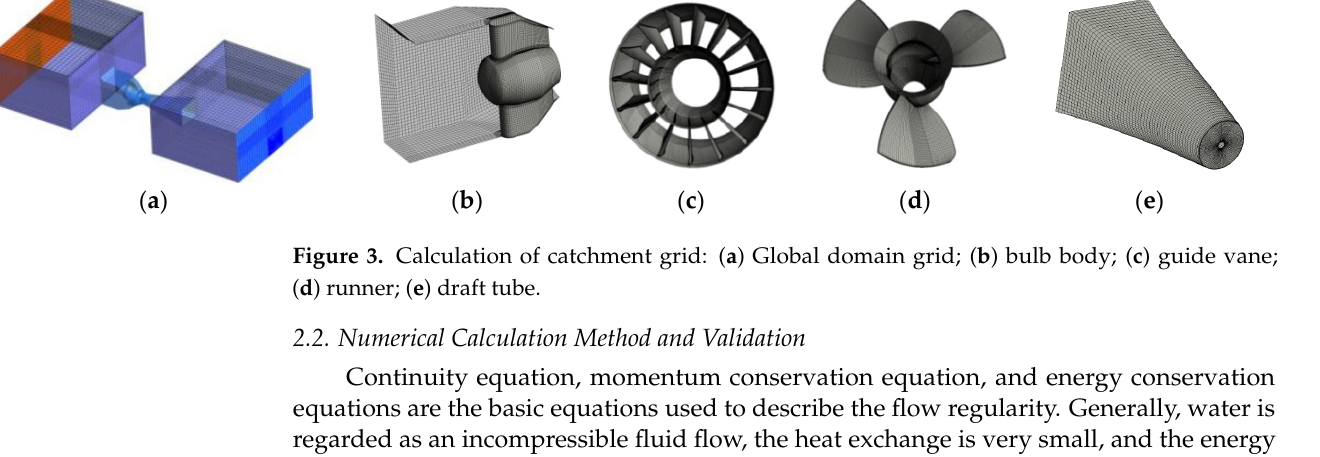
Figure 2. Grid independence verification.